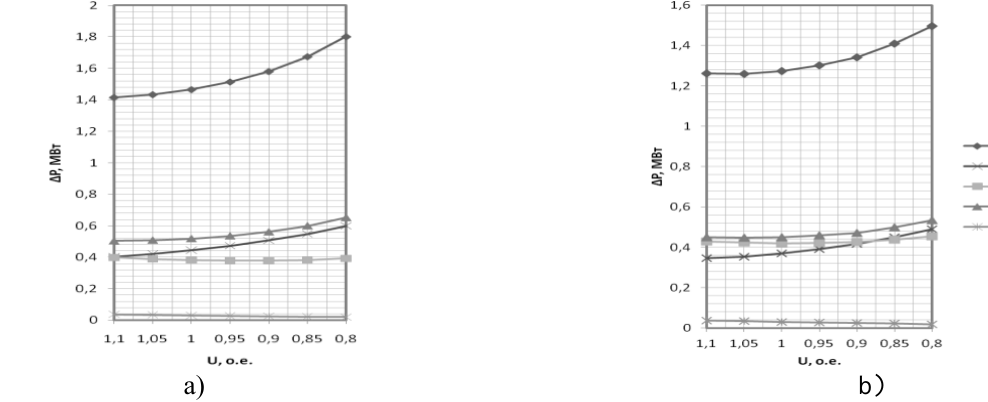
Fig. 2. Statistical characteristics of the active power losses for TP-26: a) when Кз = 0.9, b) when Кз = 0.8.